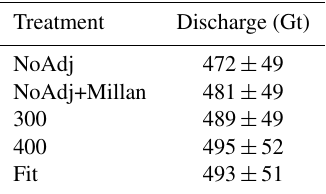
Table A2. Effect of different thickness adjustments on baseline dis-